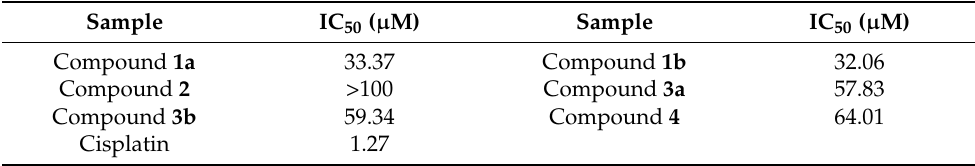
Table 3. The IC 50 value of compounds on NCI-H460 cells ( µ